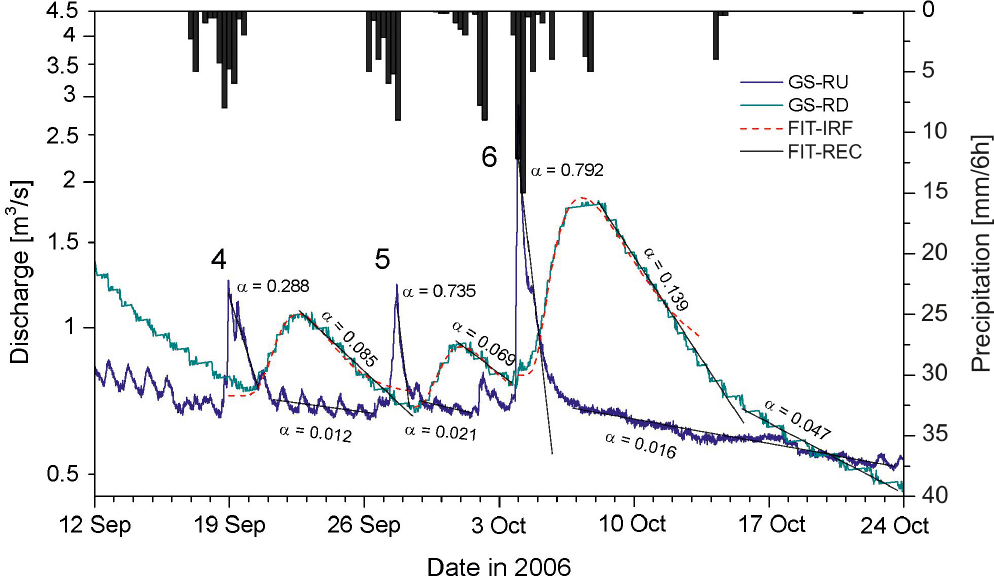
Figure 9. Discharge characteristics in late summer and autumn of 2006 in the Reintal demonstrating damping effects of the series of alpine alluvial/rockfall deposits. GS-RU: discharge from the karst spring upstream the alluvial/rockfall aquifer; GS-RD: discharge downstream at the outlet of the aquifer system; FIT-IRF: fit of impulse–response function; and FIT-REC: fit of recession